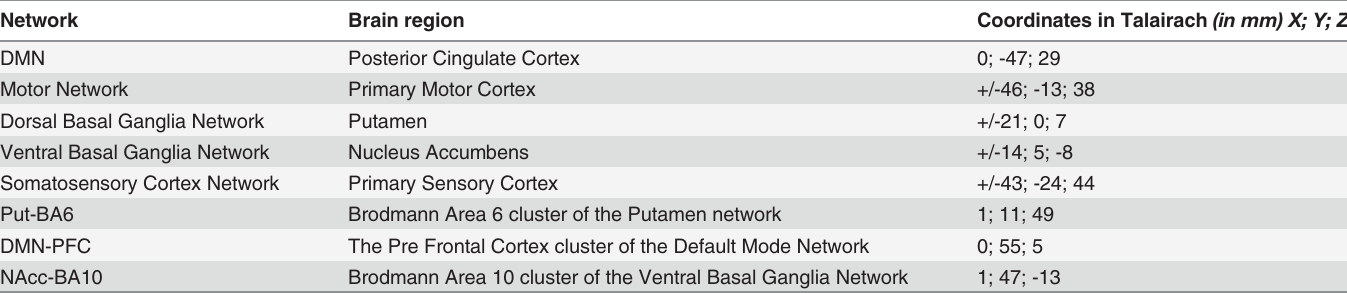
Table 1. Seed placement in humans for; DMN, motor network, dorsal basal ganglia network, and ventral basal ganglia network. Network Brain region